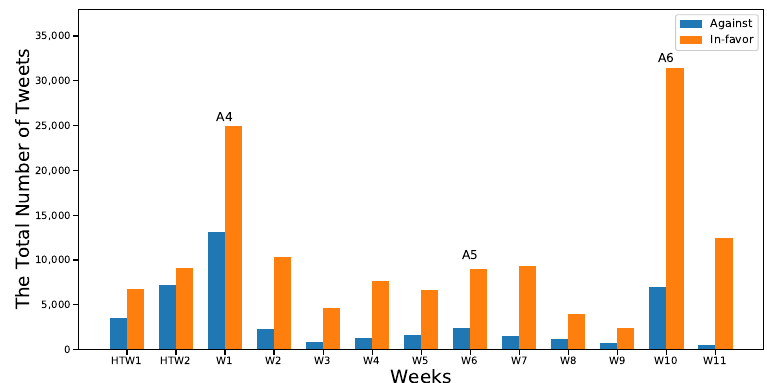
Figure 4. Distribution of cleaned tweets collected in the second